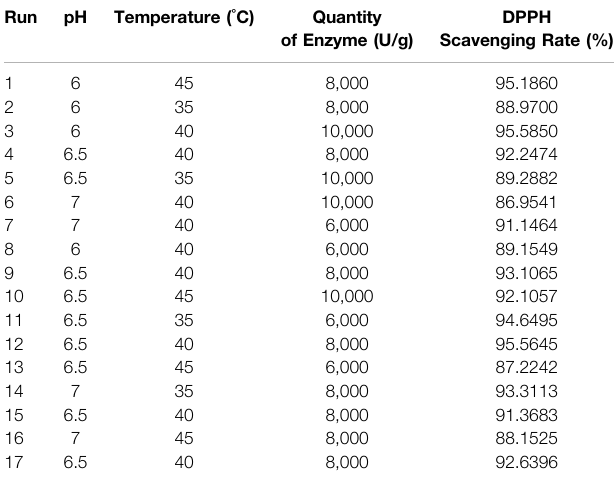
TABLE 2 | Experimental design and results for optimization of extraction parameters by response surface methodology